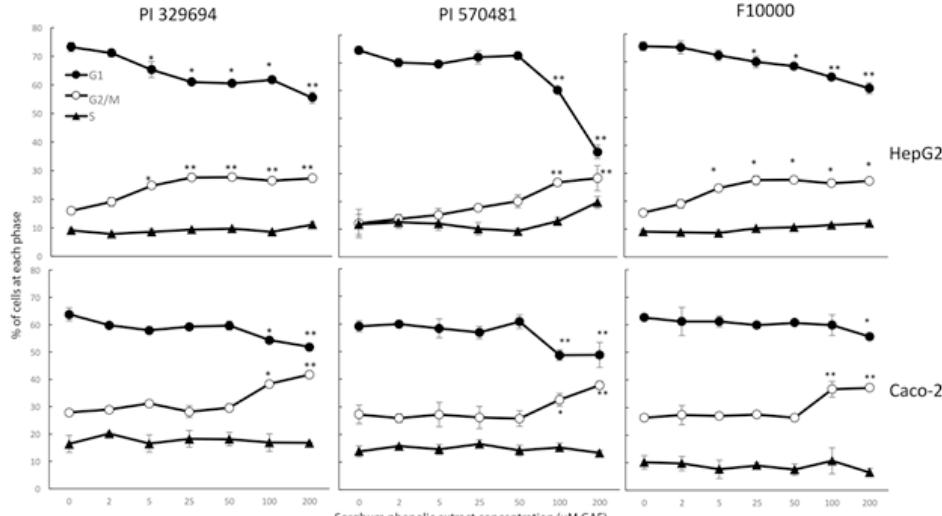
Figure 3. Cytostatic effect of representative sorghum phenolic extracts in HepG2 and Caco-2 cell lines. Cells were treated with sorghum phenolics extracted from the representative sorghum accessions PI329694 and PI570481 at 0–200 μ M GAE for up to 72 h, and then cell cycle was monitored by a DNA flow cytometric analysis. Values are expressed as Mean ± SD ( n = 3), * p < 0.05, ** p < 0.01 versus the vehicle control.